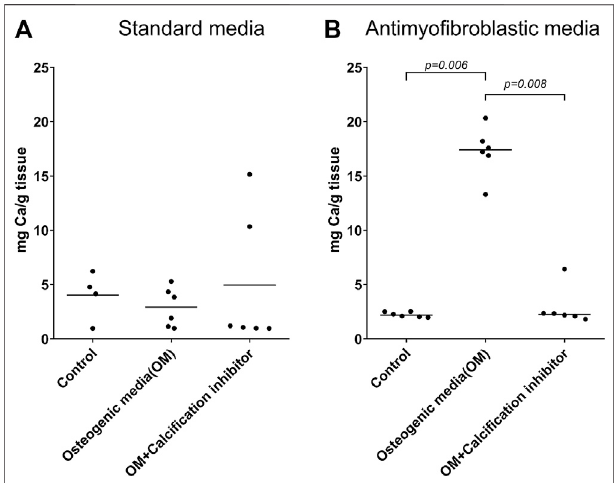
FIGURE2| Calciumaccumulationinwholepiglea fl etscultivated forfour weeks in standard (A) and antimyo fi broblastic (B) medium under control conditions, osteogenic stimulation and osteogenic stimulation with addition of the known calci fi cation inhibitor SNF472. The amount of calcium was measured by inductively coupled plasma optical emission spectroscopy. The dataareindividualvaluesandmedian. Statisticalanalysis:nonparametricone- way ANOVA (Kruskal – Wallis test) with Dunn ’ s